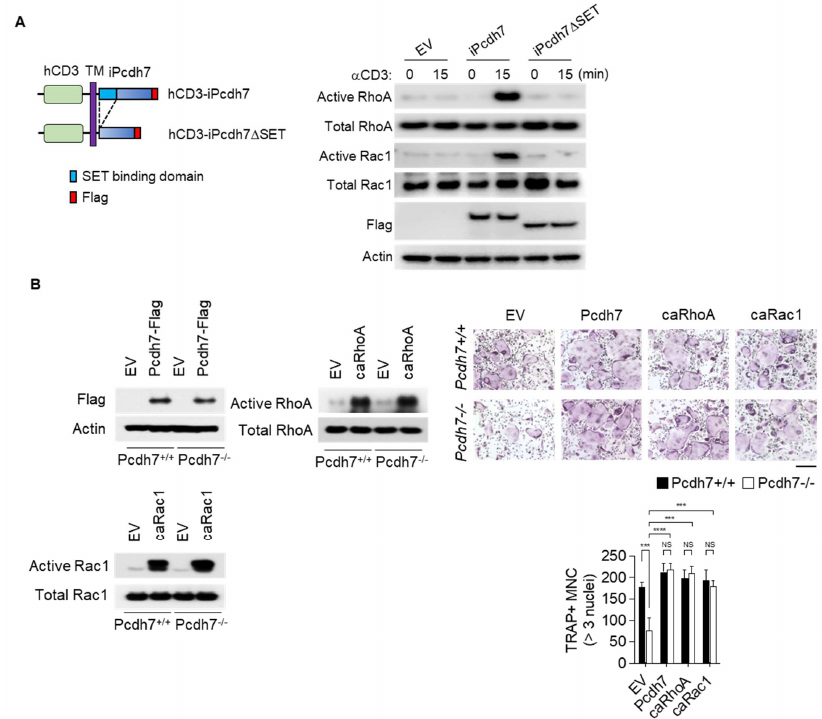
Figure 4. Crosslink of Pcdh7 intracellular region is critical for activation of RhoA and Rac1, and formation of osteoclasts. ( A ). Schema of human CD3 extracellular-transmembrane region fused to Pcdh7 full intracellular region (hCD3-iPcdh7) or Pcdh7ΔSET intracellular region (hCD3-iPcdh7ΔSET) chimeric proteins. Both constructs were Flag-tagged at C-terminus (left). Pcdh7 −/− BMMs retrovirally transduced with the indicated vectors were cultured with M-CSF + RANKL for a day and stimulated with anti-hCD3 antibody for 15 min. Total cell lysates were used to detect the activated forms of RhoA and Rac1 (right). ( B ). Pcdh7 +/+ and Pcdh7 −/− BMMs retrovirally transduced with the indicated vectors were cultured with M-CSF + RANKL for 3 days to induce osteoclasts. Expression of transduced vectors was confirmed by Western blotting (left). The number of TRAP + multinucleated cells (3 nuclei or more per cell) is shown (right). The scale bar represents 100 μm. Data are shown as the mean ± S.D. *** p < 0.001, **** p < 0.0001.